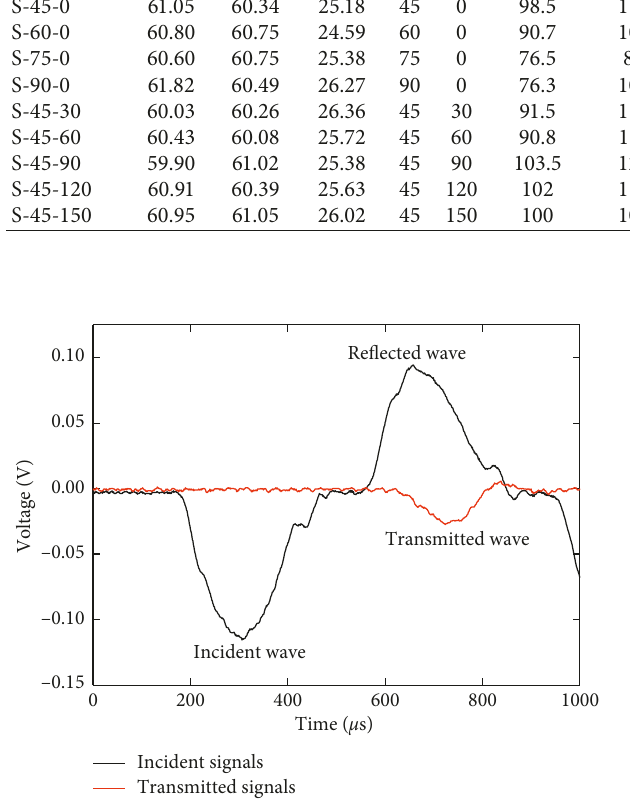
Figure 3: Typical impulse waveforms of the sandstone specimen S-60-0.